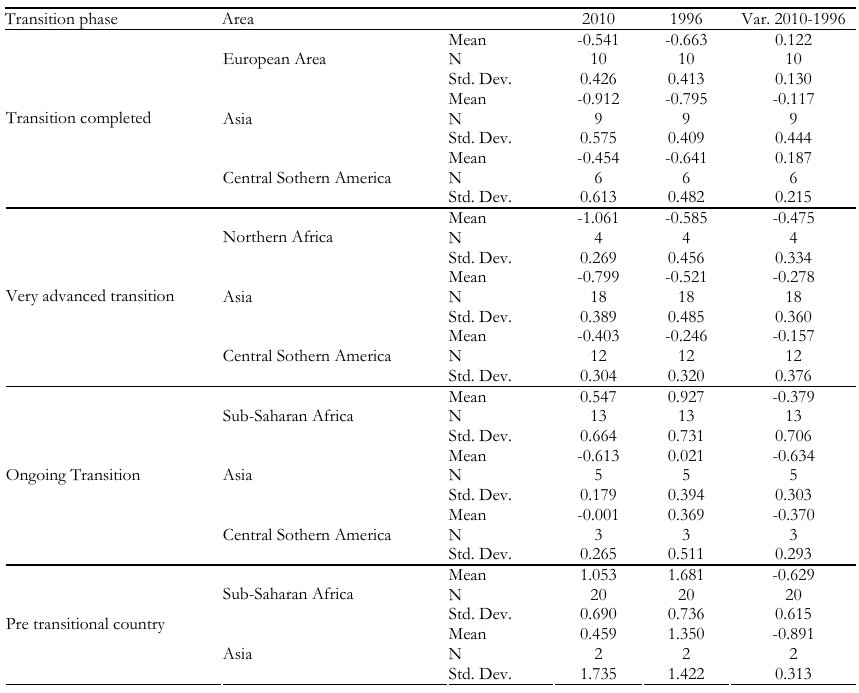
Mean scores and reduction for factor 1 by transition phase and